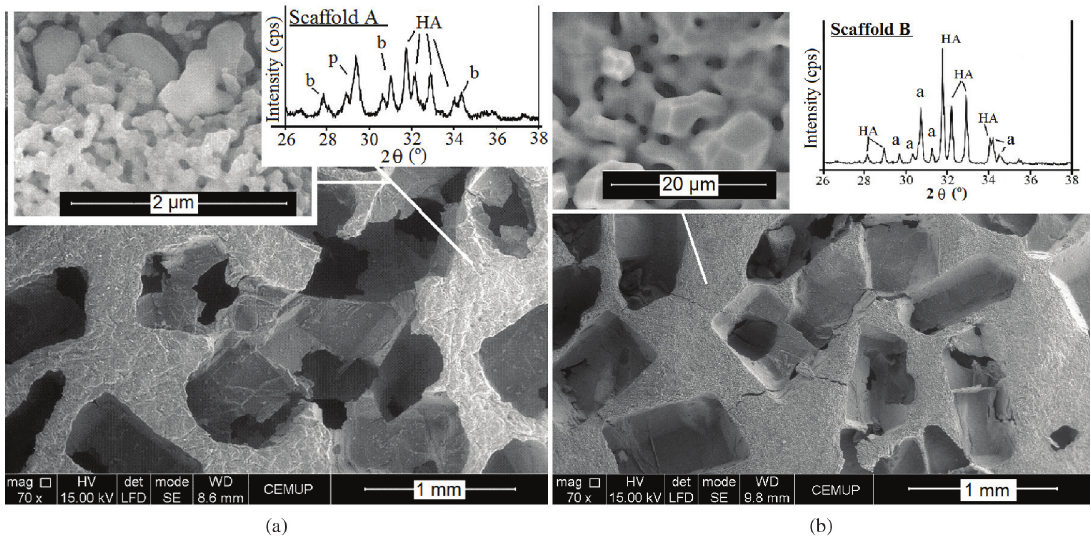
Figure 2. (a) Pores on scaffold A calcined at 725 °C. In the details of “Figure a” surface morphology at higher magnification may be seen and the XRD analysis (b: beta-TCP; p: pyrophosphate; HA: hydroxyapatite). (b) Pores on scaffold B sintered at 1330 °C. In the details of “Figure b” is shown the surface of scaffold, and the XRD analysis (a: peak of the alpha-tricalcium phosphate; HA: peak of